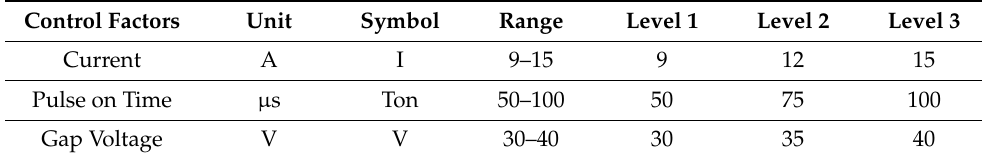
Table 1. Wire Electrical Discharge Machining (WEDM) parameters and its levels.